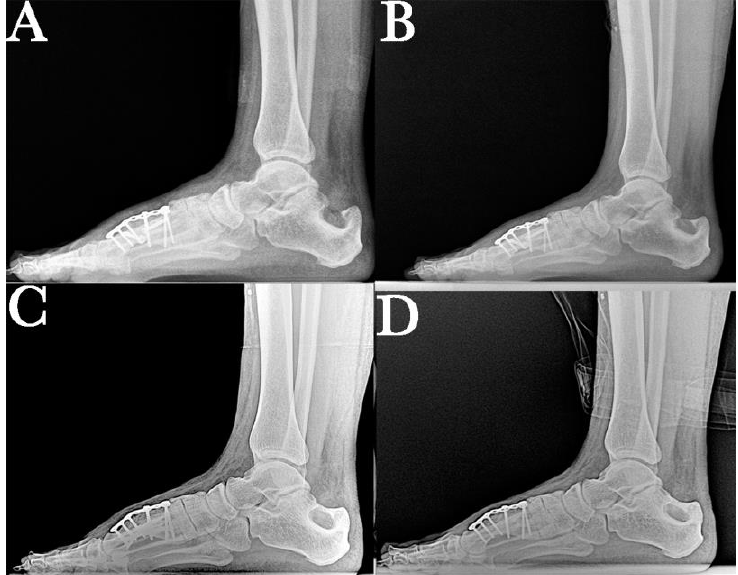
Figure 5. Correct position of the first metatarsal in the transverse plane and the evolution of the osseointegration process of an autologous graft. Images at ( A ) 6-month, ( B ) 12-month, ( C ) 18-month, and ( D ) final 24-month follow-up after surgery, showing bone callus consolidation and remodeling, and maintaining correction of the analyzed radiographic parameters.